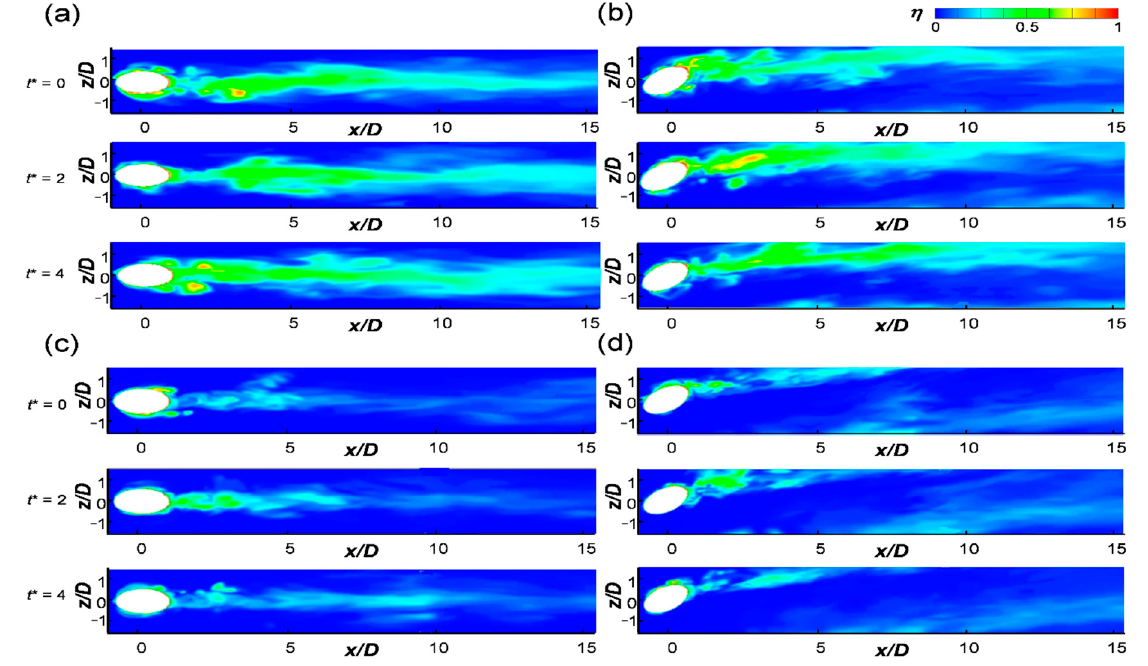
Figure 13. Instantaneous adiabatic film cooling effectiveness distributions: ( a ) M = 0.5, β = 0°; ( b ) M = 0.5, β = 30°; ( c ) M = 1.0, β = 0°; and ( d ) M = 1.0, β = 30°.